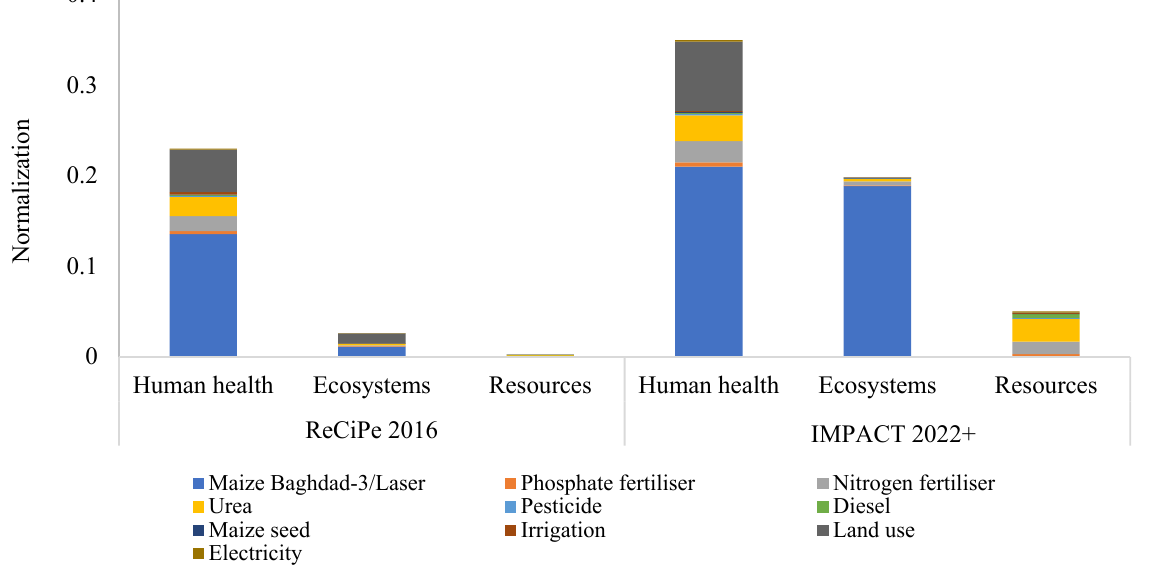
Figure 6. Normalization of substance impacts on human health, ecosystems, and resources using the two endpoint methods (ReCiPe and IMPACT 2002+).